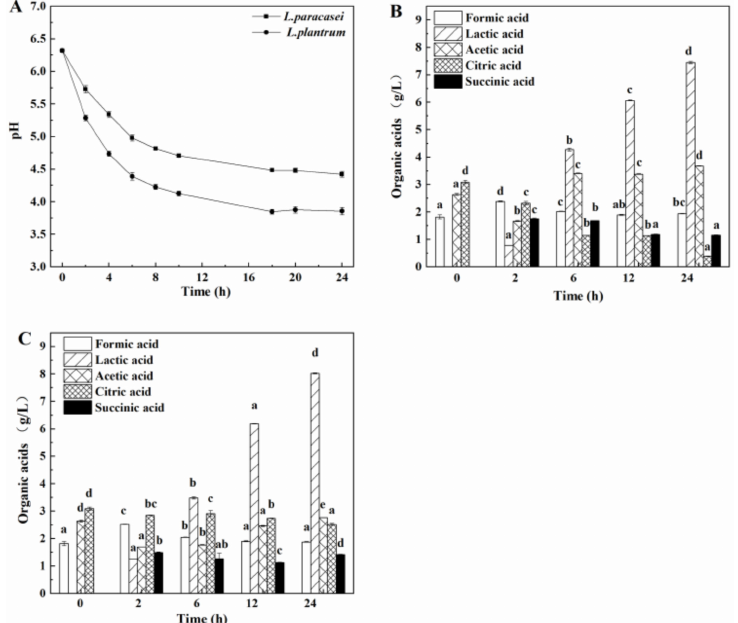
Figure 1. Changes of pH during the fermentation of acidic whey using L. paracasei and L. plantarum ( A ). Changes of organic acids in acidic whey during the fermentation using L. paracasei ( B ) and L. plantarum ( C ). Note: Different letters of the same column filling mean significant differences ( p <